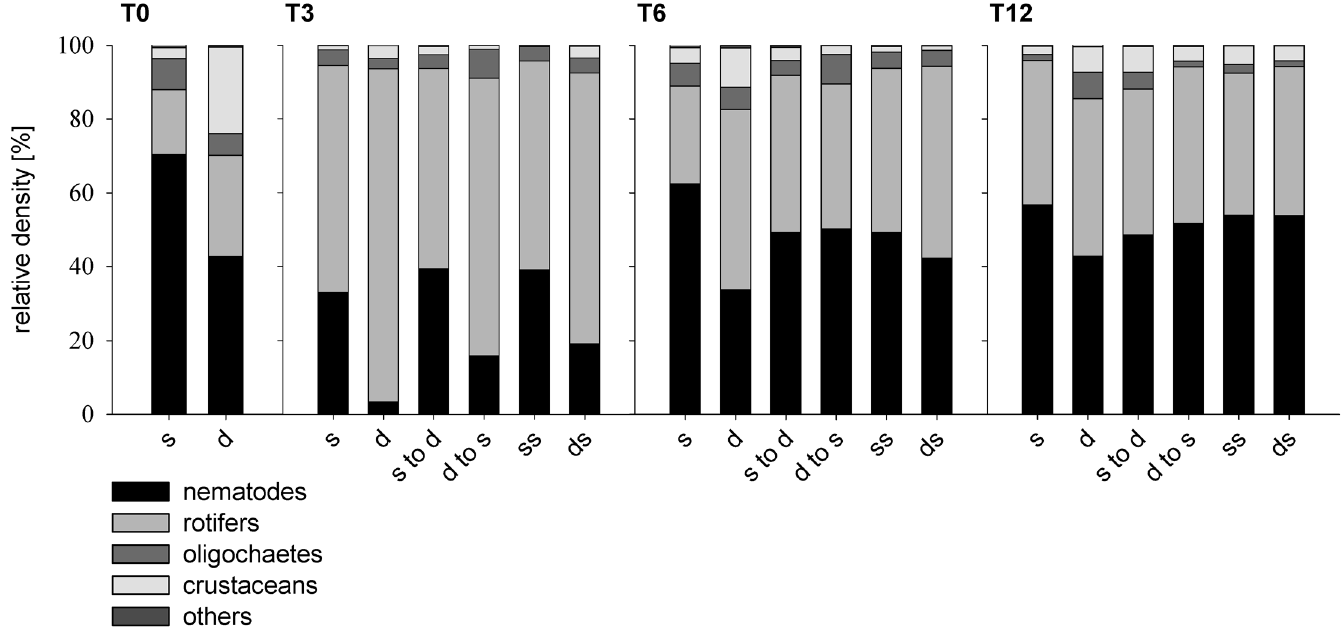
Fig 2. Relative meiofaunal density. Densities (mean, N = 5) of nematodes, rotifers, oligochaetes, micro-crustaceans (copepods, cladocerans, and ostracodes) and other meiofauna (water mites and tardigrades) in the periphyton of Lake Erken in response to six different depth treatments (shallow: s, deep: d, shallow-to-deep: s to d, deep-to-shallow: d to s, shallow-shaded: ss and deep-shaded: ds) at four sampling dates (T0: start, T3: 3 weeks, T6: 6 weeks, and T12: 12